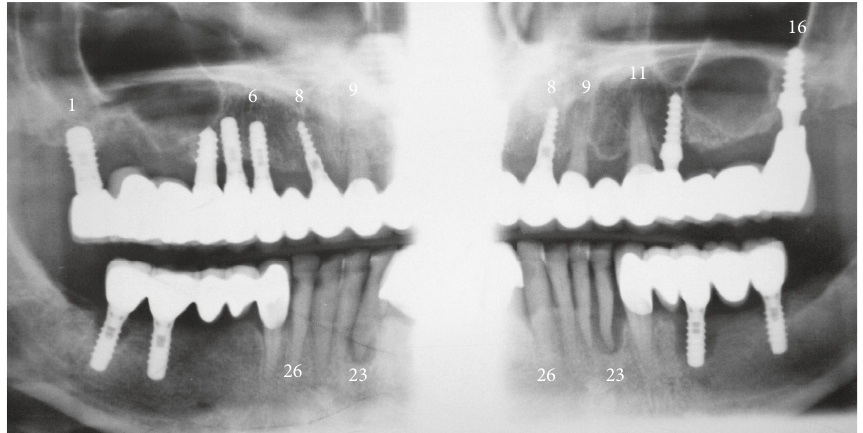
Figure 10: Original not modified OPG of previous treatment with significant distortion. Please compare with Figure 3(b). Double representation of teeth and implants is